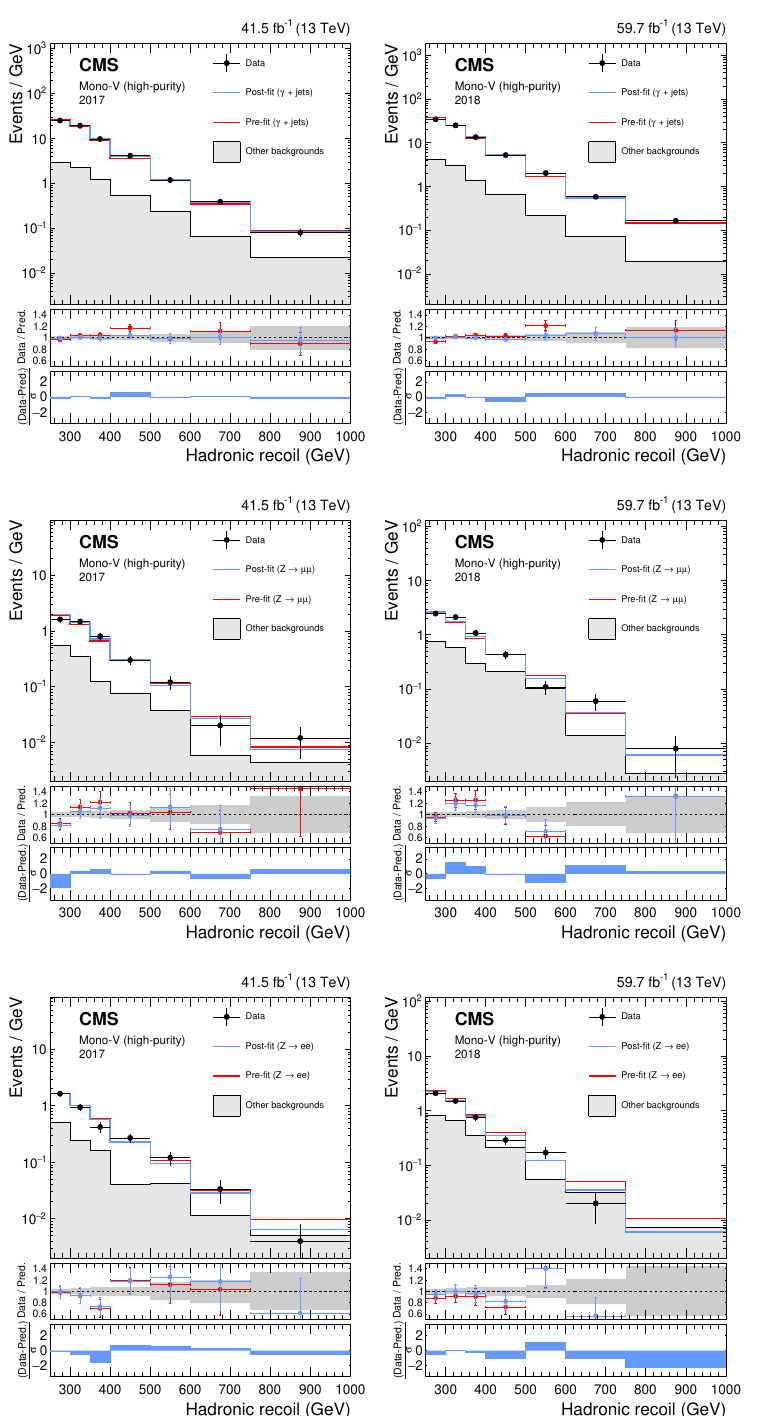
Figure 17 . Hadronic recoil distributions in the photon (upper), dimuon (middle) and dielectron control regions (lower) in the high-purity mono-V category. The “Other backgrounds” include QCD multijet production (photon control region), and top quark, diboson, and W + jets processes (dimuon and dielectron control